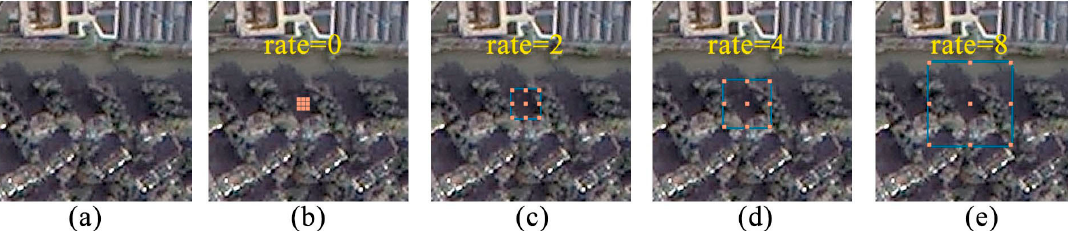
Figure 4. Examples of dilated convolution with different rates. ( a ) is the sample image; ( b – e ) are examples of dilated convolution with dilation rate 0, 2, 4, 8, respectively.